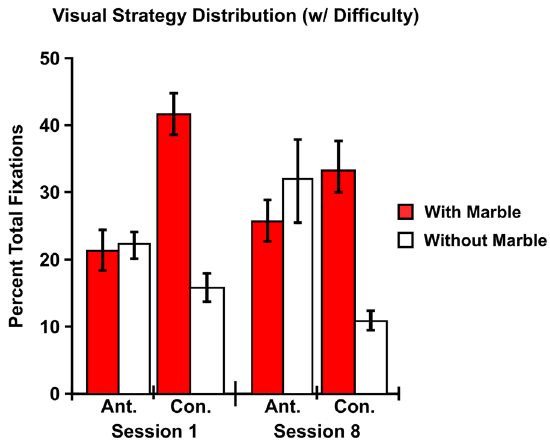
Figure 4. Visual Strategy Distribution (w/Difficulty) – Including difficulty in the GEE model resulted in a main effect of difficulty with strategies occurring while transporting the marble, particularly confirmatory strategies, being more prominent than those occurring without the marble. In addition, the reversal in distribution for anticipatory and confirmatory strategies after training (Fig. 3A) remains. Ant. = Anticipatory. Con. = Confirmatory. Error bars indicate SEM. N = 12.